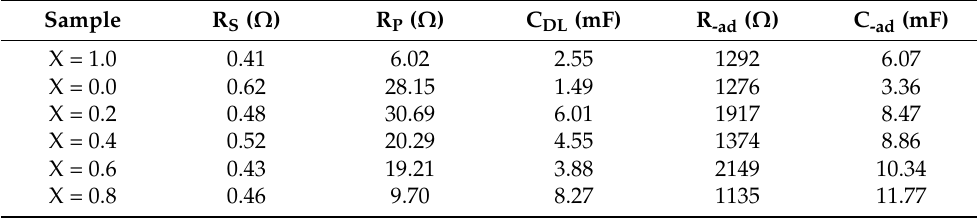
Table 6. EIS—Results of fitting of the impedance spectra reported in Figure